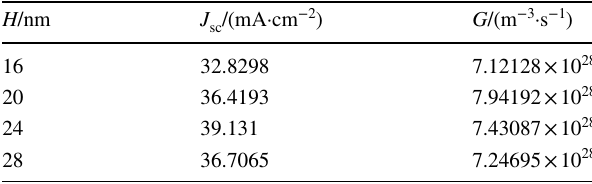
Table 3 Performance of the graphene/Si QDIBSC versus